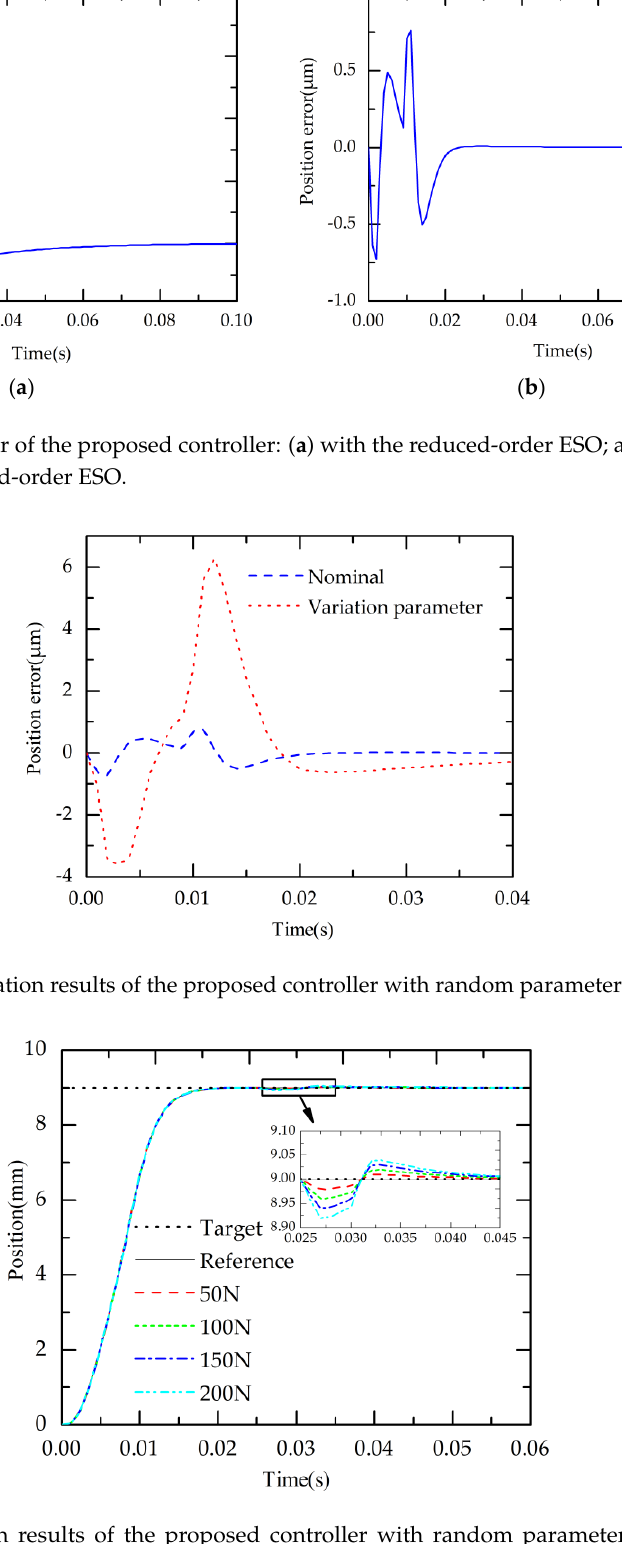
Figure 11. Simulation results of the proposed controller with random parameter variation and external disturbance.